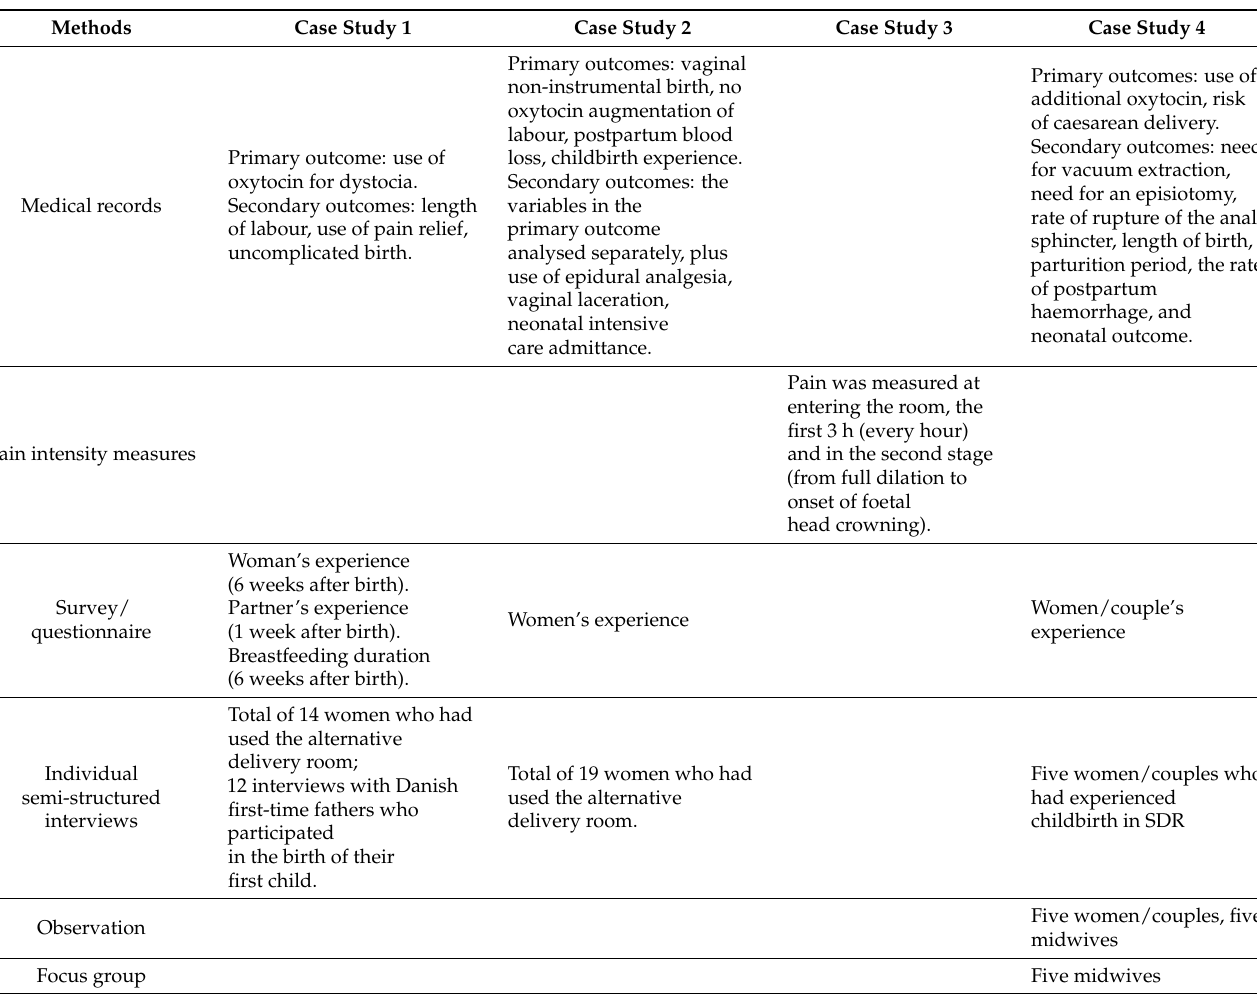
Table 6. Impact evaluation